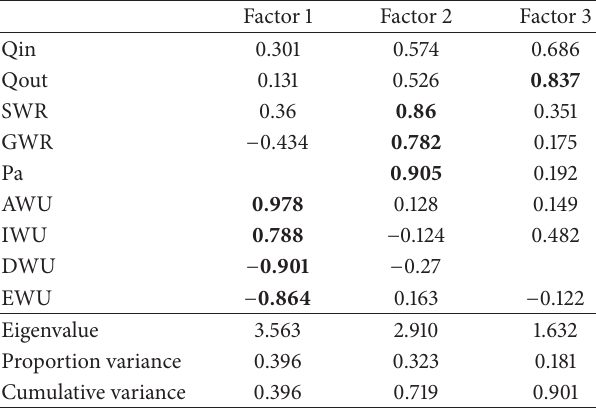
Table 5: Loadings of variables to each factor.